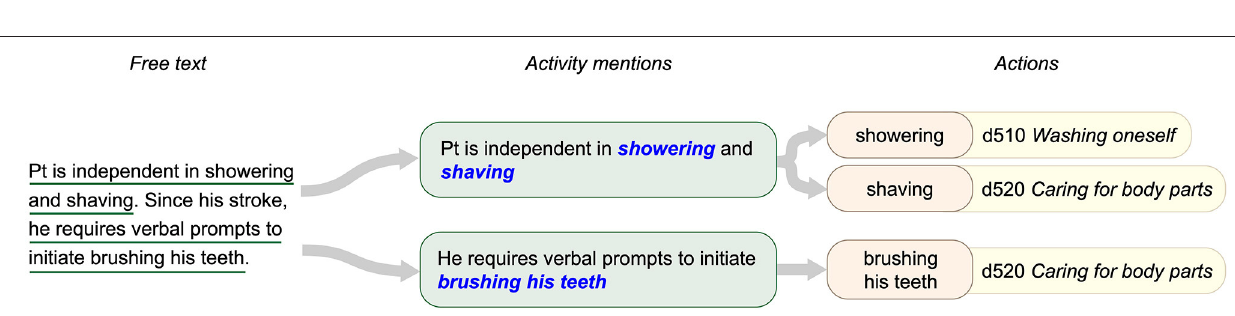
FIGURE 1 | Flowchart illustration of the annotation process. Data sources and document counts are provided for Mobility and Self-Care/Domestic Life annotations separately.